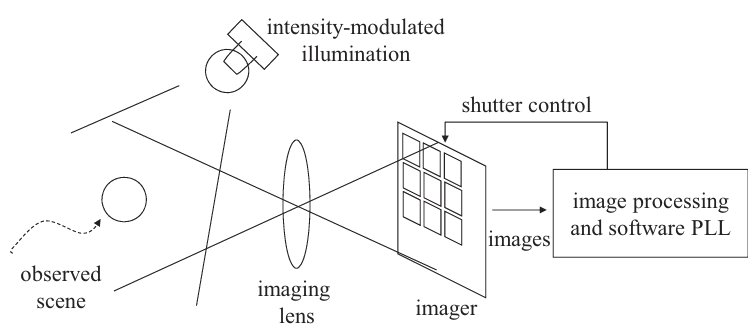
Figure 1. Conceptual diagram of the proposed illumination-based